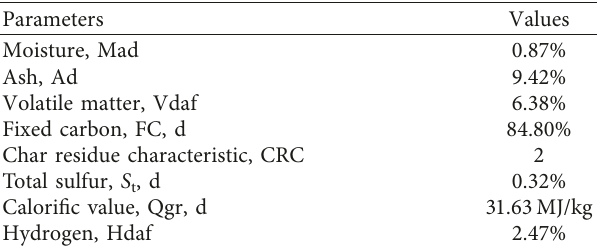
Table 1: Proximate analysis results of the anthracite used in this